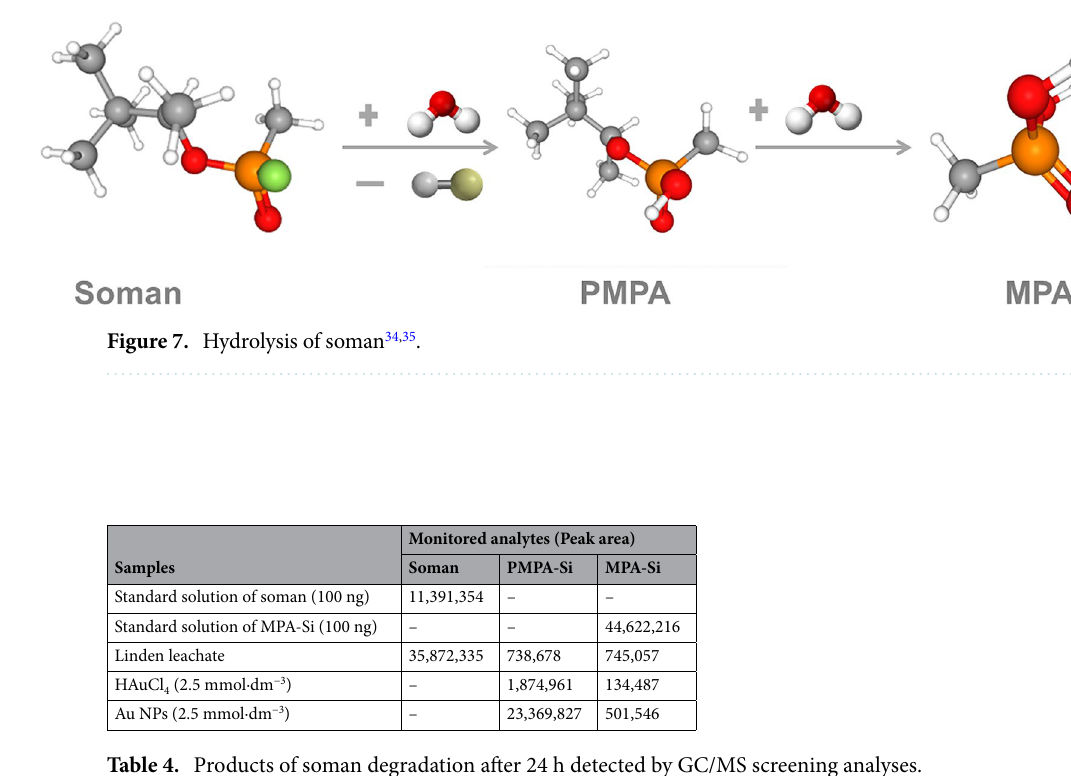
Table 4. Products of soman degradation after 24 h detected by GC/MS screening